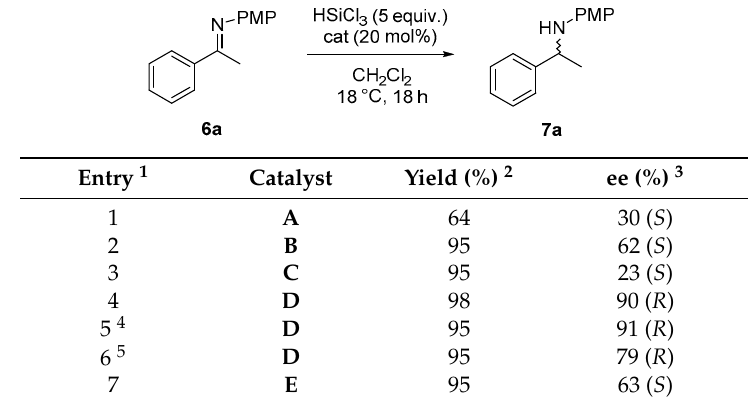
Table 1. Screening of supported catalysts in the reduction of imine 6a with HSiCl 3 .